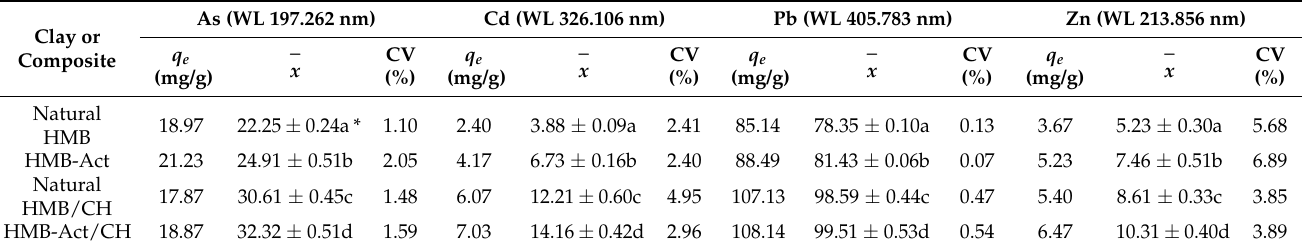
Table 3. Metals adsorption (%).